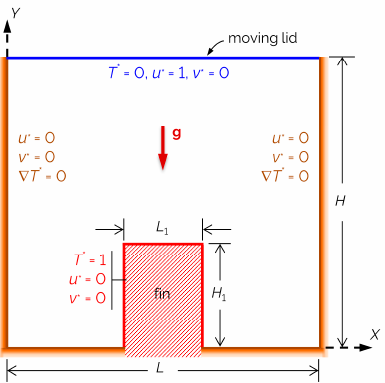
Figure 1. Computational domain with boundary conditions for the investigation of entropy generation CuO-water nanofluid.